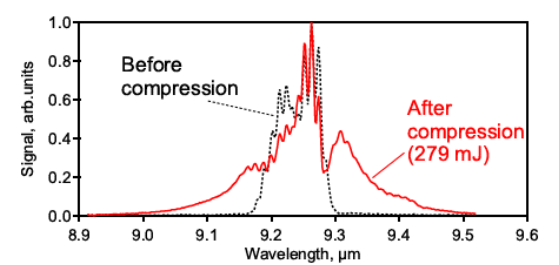
Fig. 3. A typical measured spectra of a laser pulse before and after compression at the energy corresponding to the optimal compression.